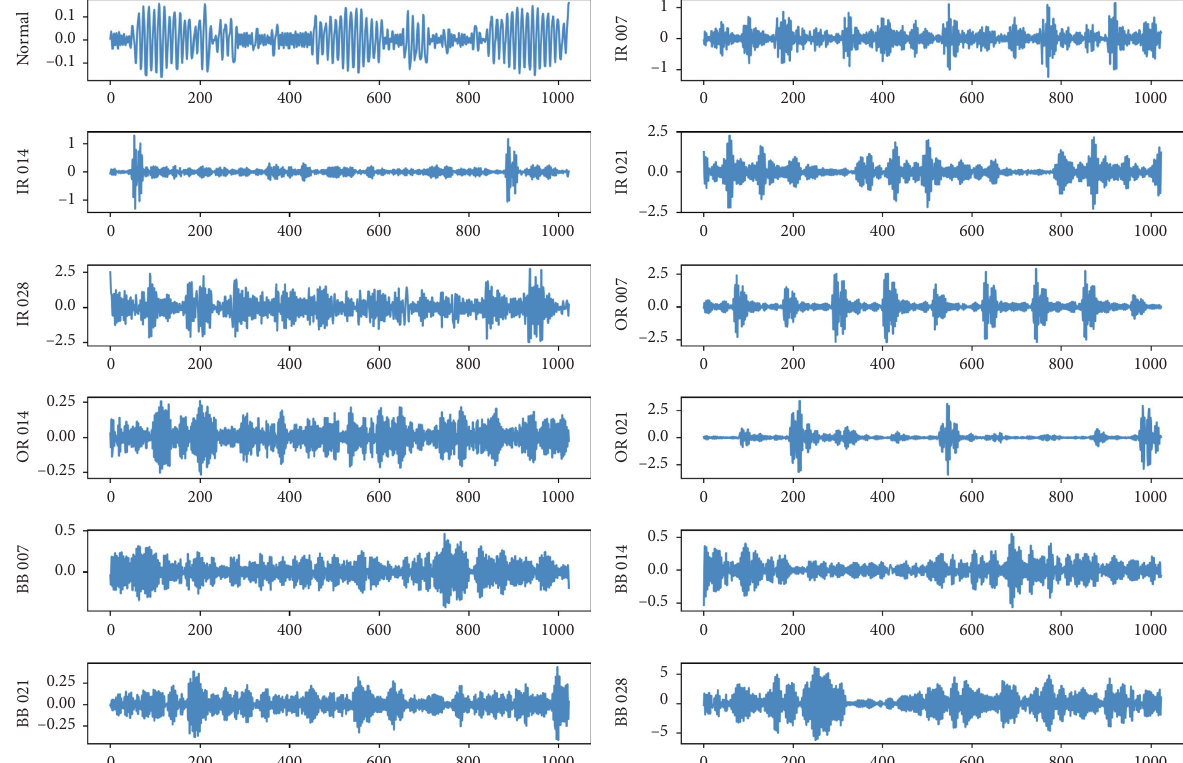
Figure 3: Plots of the best IMFs selected on the basis of Pearson correlation coefficient. A drive-end sample of size 1024 points from each of the 12 classes has been depicted.